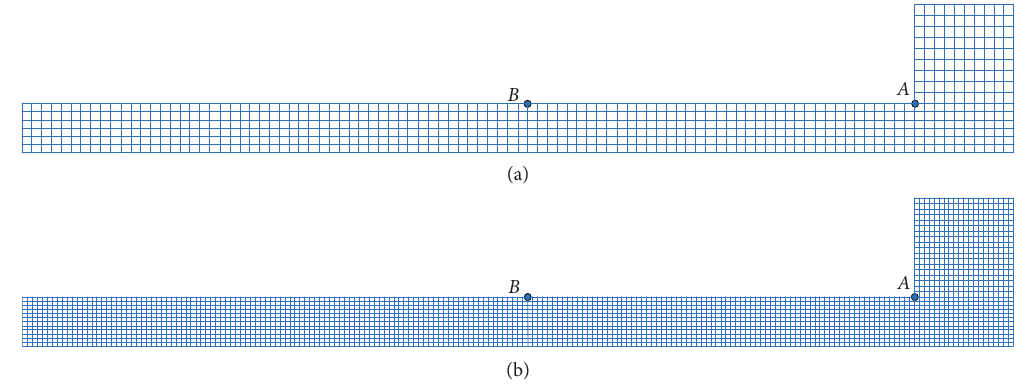
Figure 24: Discrete meshes of PCMs energy harvester. (a) Elements of CSFEM. (b) Elements of FEM. Table 5: The material properties of the PCMs energy harvester were calculated using AHM. Volume